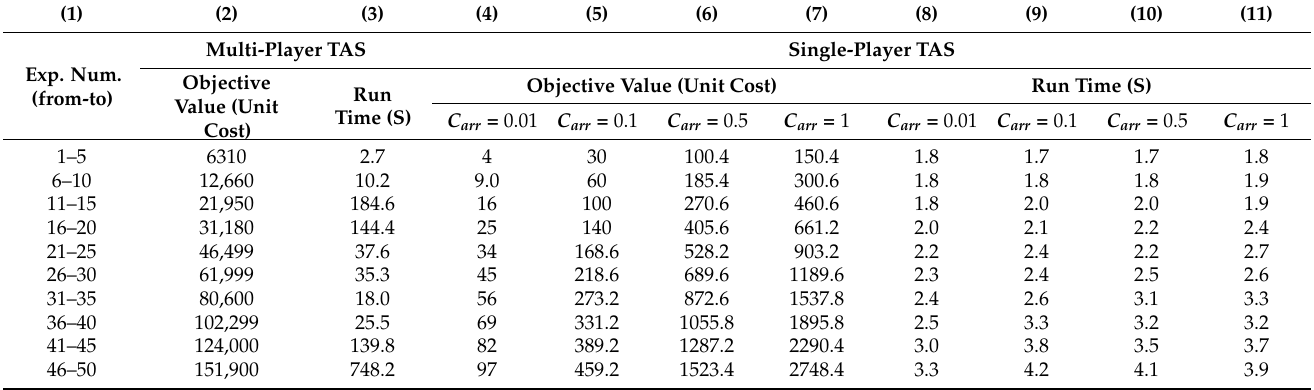
Table 6. Results of